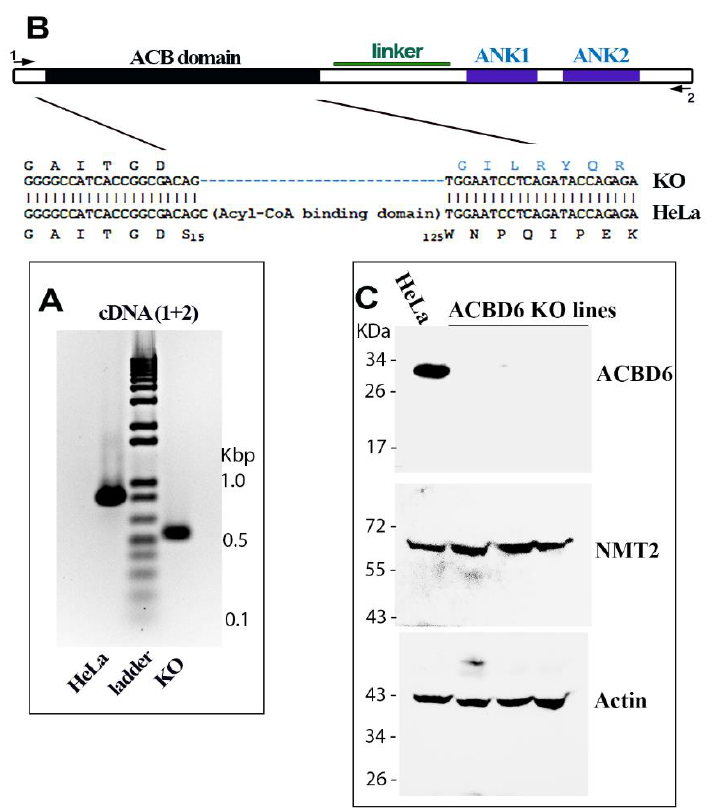
Figure 3. Disruption of the ACBD6 gene in HeLa cells. An out-of-frame deletion of the region encoding the entire ACB domain of the ACBD6 gene was obtained in HeLa cells. ( A ) . The result of PCR reactions of cDNAs obtained from RNAs isolated from the ACBD6.KO and the parent HeLa cells with ACBD6 primers 1 and 2 is shown. The full-length ACBD6 cDNA ( ≈ 860 base pairs) present in normal cells is absent in the ACBD6.KO cells and a single cDNA ( ≈ 530 bp) was detected establishing that no unaltered copy of the ACBD6 gene was present in the ACBD6.KO cells. The ladder was the 1 Kb Plus DNA Ladder (ThermoFisher Scientific). ( B ). Deletion of the region coding the ACB domain was confirmed by sequencing of the cDNA. The deletion results in the out-of-frame fusion of the codons encoding Serine 15 and Tryptophan 125 preventing formation of an ACB truncated product. Primers used for the PCR amplification presented in panel A are indicated as 1 and 2. ( C ). Western-blot detection were performed with 100 µg of cell lysate proteins obtained from the parent HeLa cells and three ACBD6.KO lines. Proteins were separated on denaturing PAGE-gradient gel. After electrophoresis, proteins were transferred on PVDF membrane and probed with monoclonal antibodies against ACBD6, NMT2 and, β -actin. The protein ladder Blue Prestained Protein Standard (New England BioLabs, Ipswich, MA, USA) is indicated on the left.